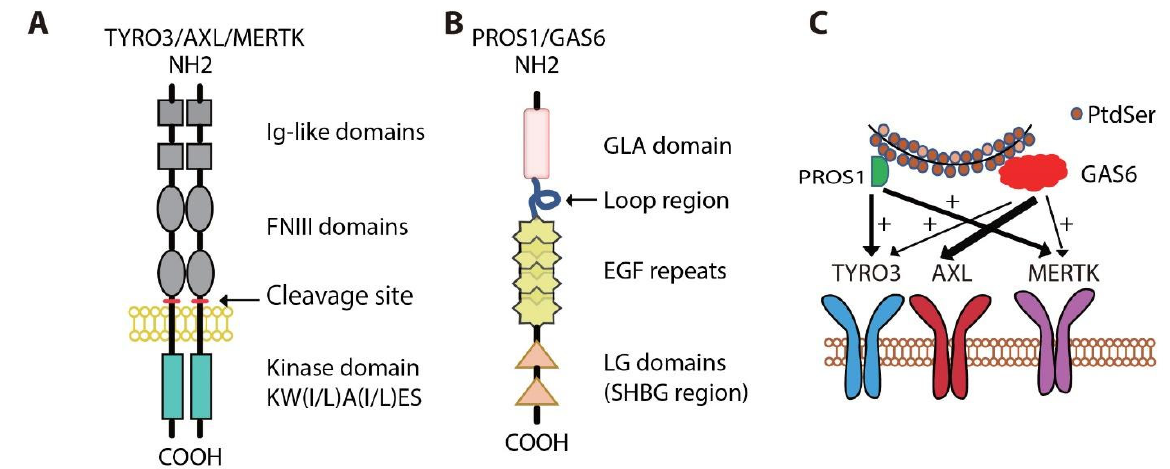
Figure 1. TAM receptors and their ligands. ( A ) TAM receptors TYRO3, AXL, and MERTK share a similar structure of two immunoglobulin (Ig)-like domains, two fibronectin type III (FNIII) domains, and an intracellular kinase domain. ( B ) GAS6 and PROS1 contain a γ -carboxyglutamic acid (Gla) domain, four EGF-like domains, and two lamine G (LG)-like domains. ( C ) Interaction of TAM receptors with their ligands GAS6 and PROS1. The thickness of the arrows indicates the binding strengths of each ligand to the TAM receptors. “+” indicates the enhanced signal in the presence of phosphatidylserine (PtdSer).